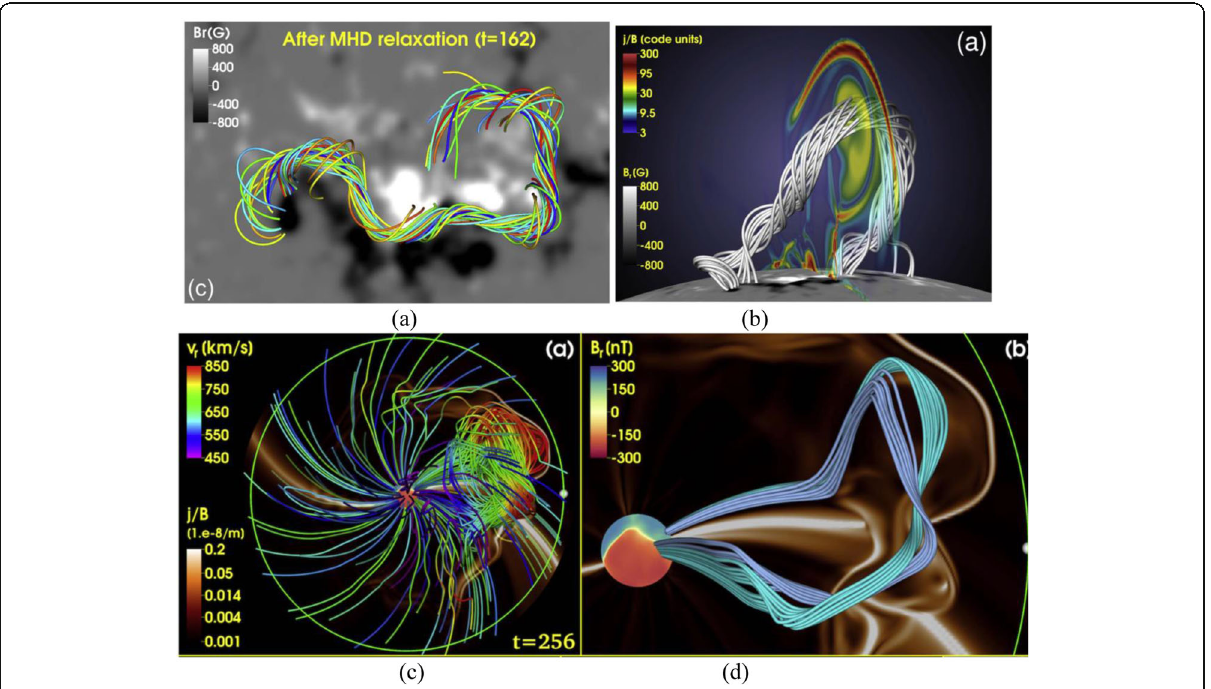
Fig. 13 a Initial flux-rope field lines with zero- β relaxation; b field lines of the flux-rope core at t = 164.10; c Interplanetary magnetic field and ICME flux rope at t = 256; d close-up view on ( c ), showing two flux bundles at the core of the flux rope (From Török et al.